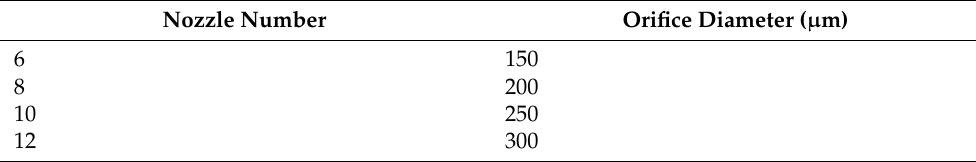
Table 4. Nozzle specification.